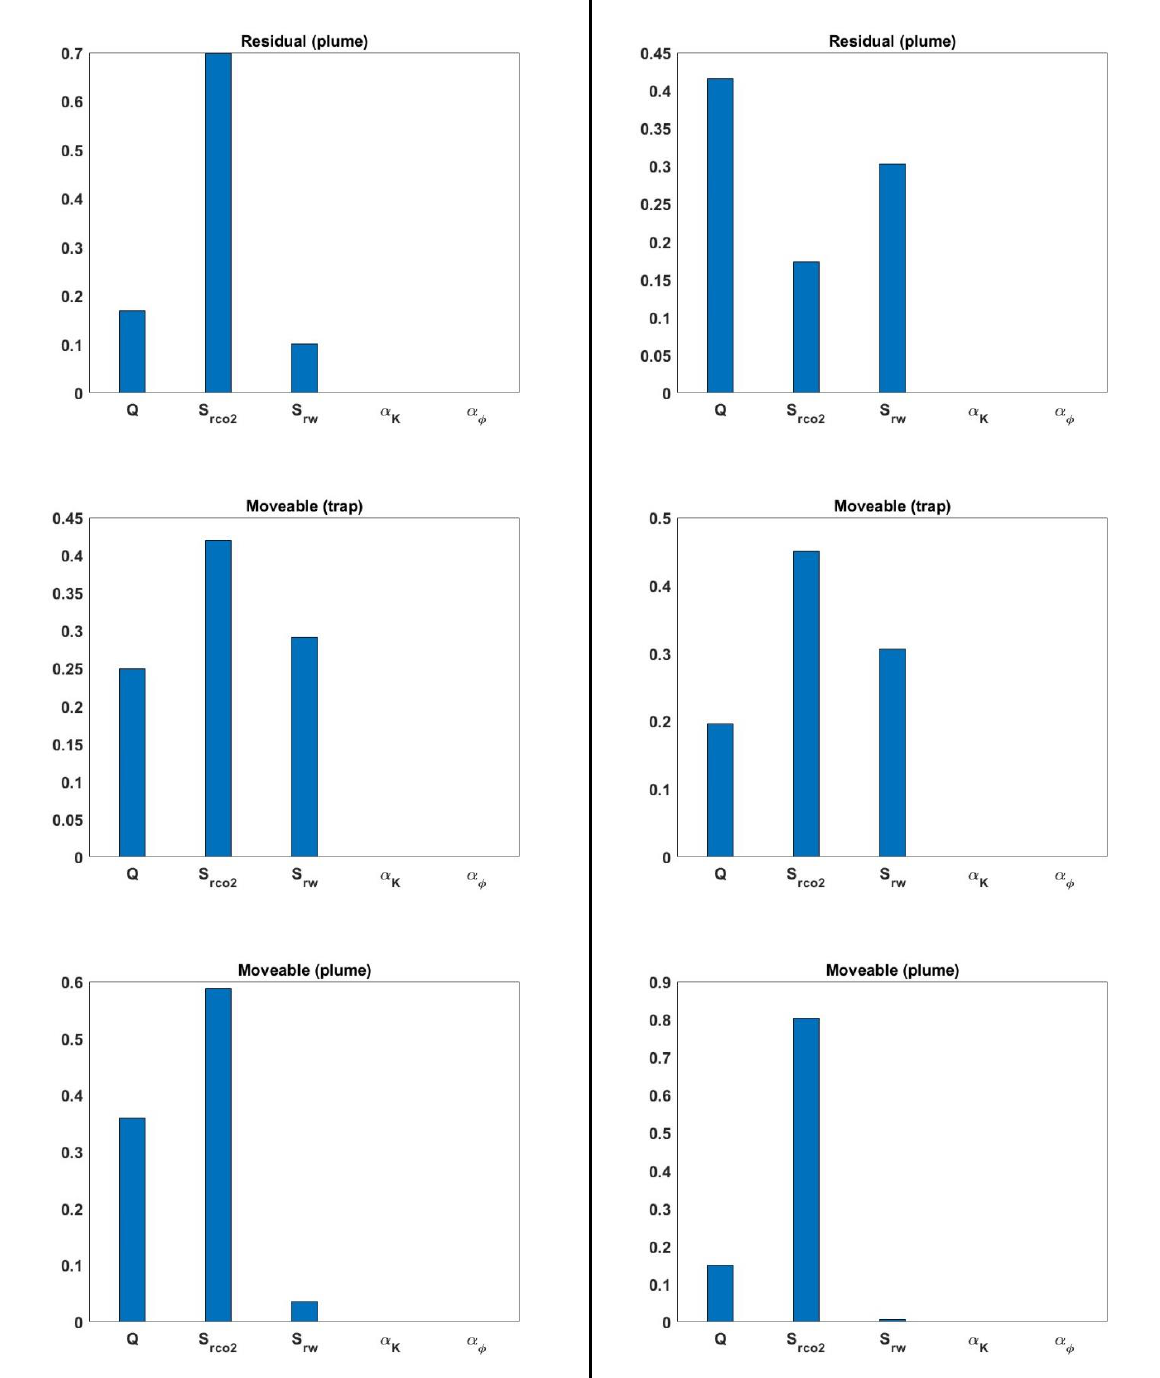
Figure 10. Global sensitivity analysis by calculating the first-order Sobol indices to determine the key contributors to the time-continuous outputs.